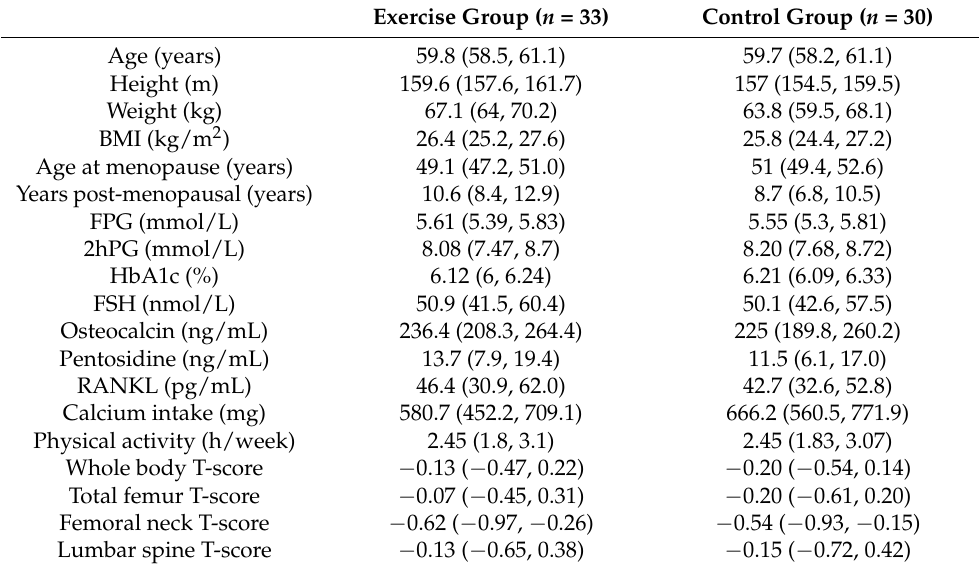
Table 1. Baseline characteristics of the exercise and control